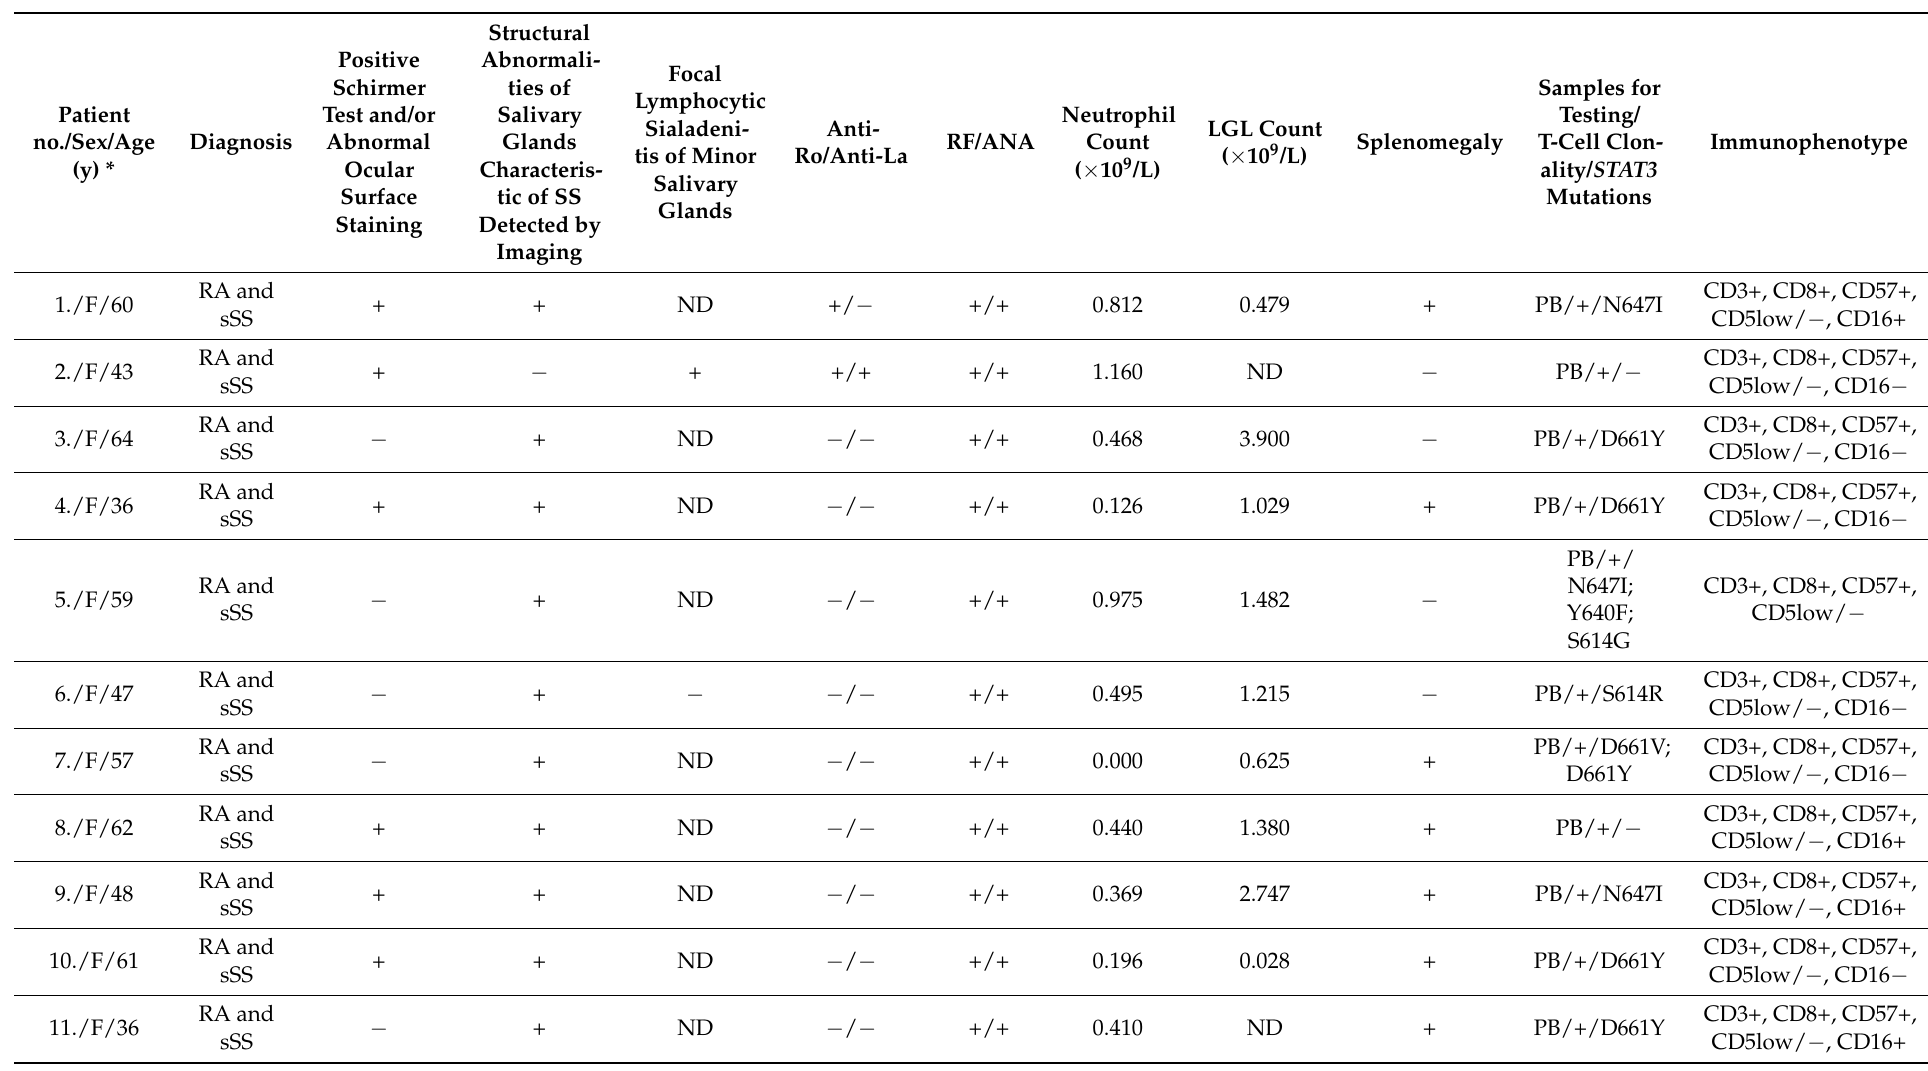
Table 1. Characteristics of 21 patients with SS-associated T-LGL